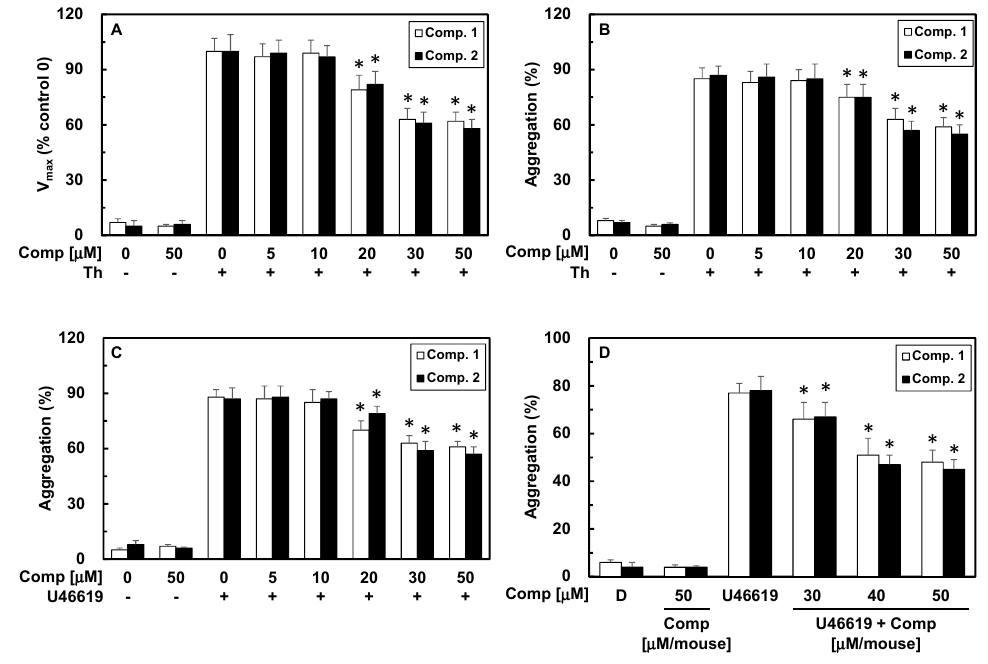
Figure 1. Effects of 1 or 2 on fibrin polymerization in human plasma. ( A ) Thrombin-catalyzed fibrin polymerization at the indicated concentrations of 1 or 2 was monitored using a catalytic assay, as described in the “Experimental Section”. The results are V max values expressed as percentages versus controls; ( B ) Effect of 1 or 2 on mouse platelet aggregation induced by 3 U/mL thrombin; ( C ) The effect of each compound on human platelet aggregation induced by 2 mM U46619; ( D ) The indicated amount of each compound concentration in DMSO was injected intravenously. The effects of each compound on mouse platelet aggregation induced by 2 µ M U46619 were monitored ex vivo . D = 0.2% DMSO is the vehicle control. Data represent the mean ˘ SEM of three independent experiments performed in triplicate. * p < 0.05 vs. Th or U46619